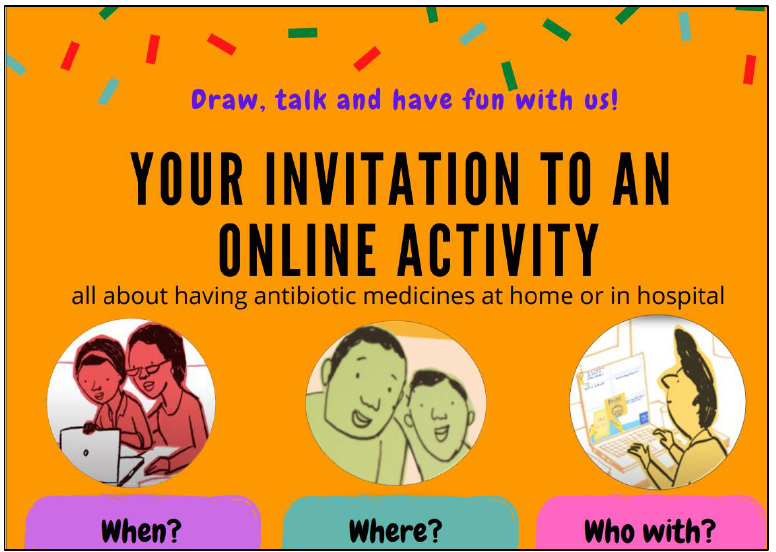
Figure 1. Examples of illustrations on the remote consultation invitation .